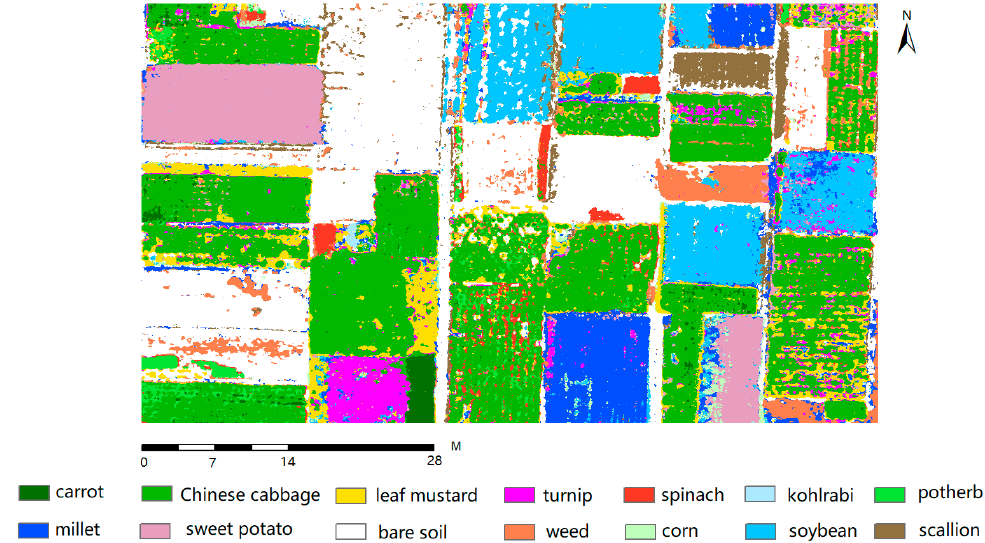
Figure 7. Vegetable map generated from the proposed ARCNN and multi-temporal UAV RGB datasets.